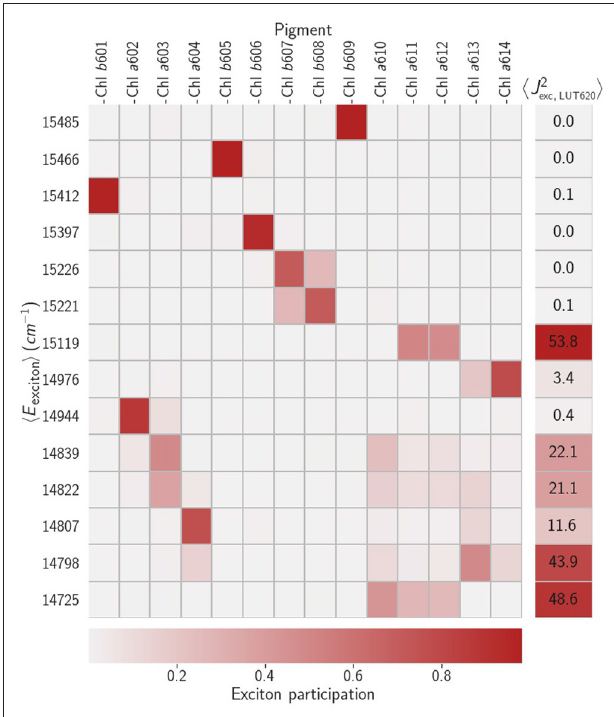
E i , of the excitonic states h i 2 c n i ( t k ) , for a typical minimum. The h| | i 0 transition on Lut. The coupling to −